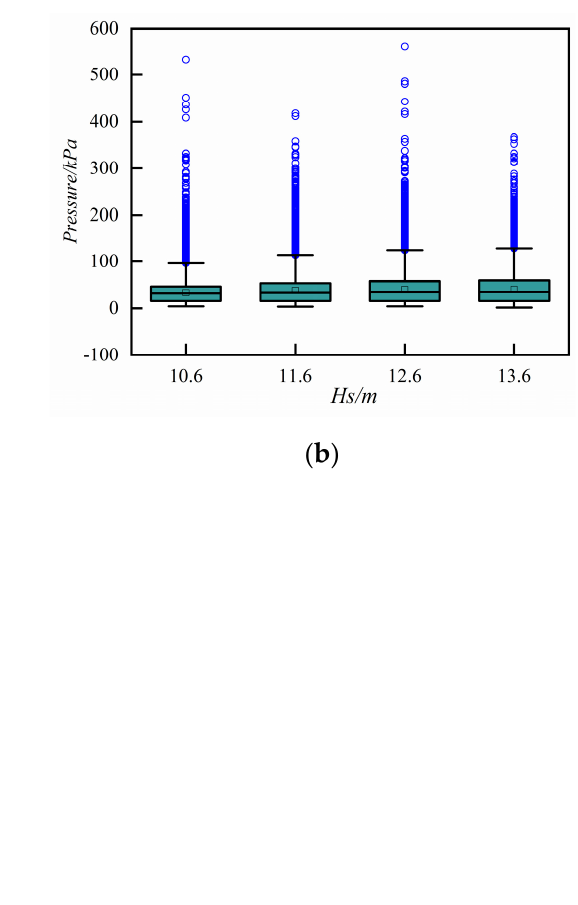
Figure 23. ( a ) β = 180°, Hs = 10.6 m, and Tp = 13.5 s, ( b ) β = 180°, Hs = 10.6~13.6 m, and Tp = 13.5 s ( c ) Number of pressures above 100 kPa recorded at point K1 on the front column at β = 180°, 225°, and 270°. Figure 23a shows the variation of slamming pressure at K1 with time for β = 180°, Hs = 10.6 m, and Tp = 13.5 s. Figure 23b shows the variation of slamming pressure with significant wave height for β = 180° and Tp = 13.5 s. Figure 23c shows the variation of slamming number with wave height and incidence angle.